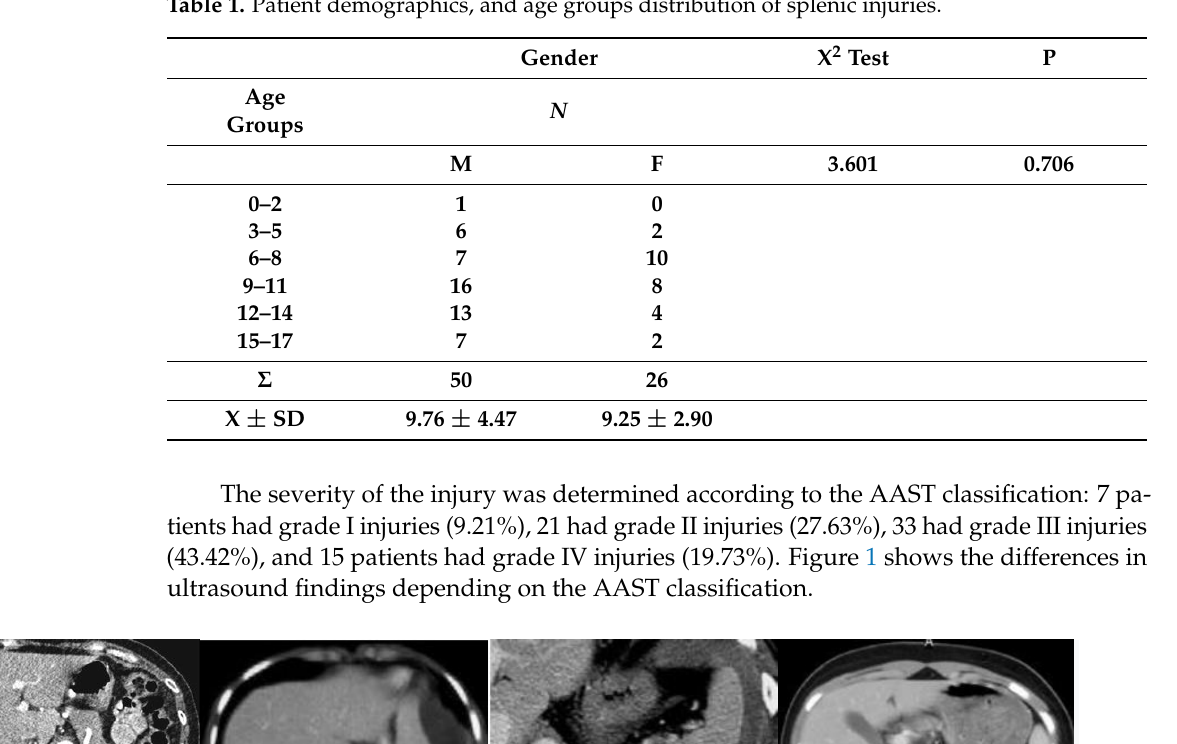
Table 1. Patient demographics, and age groups distribution of splenic injuries.